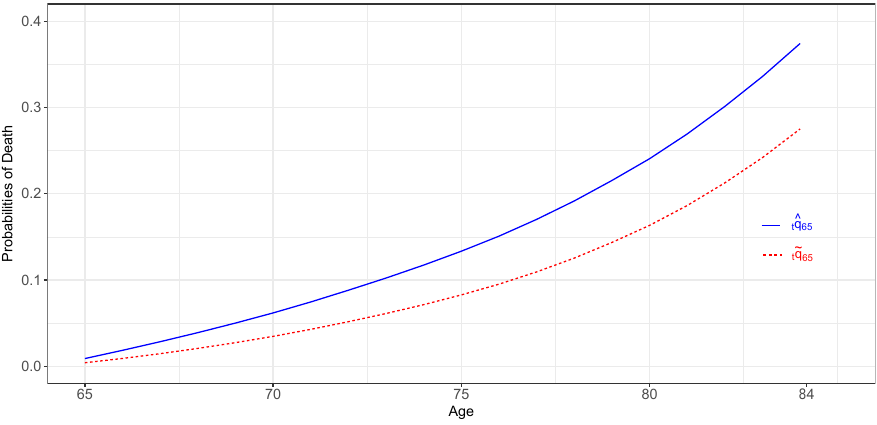
Figure 6. Death probabilities t (cid:98) q cred x and t (cid:101) q cred x under the SPM method for females.